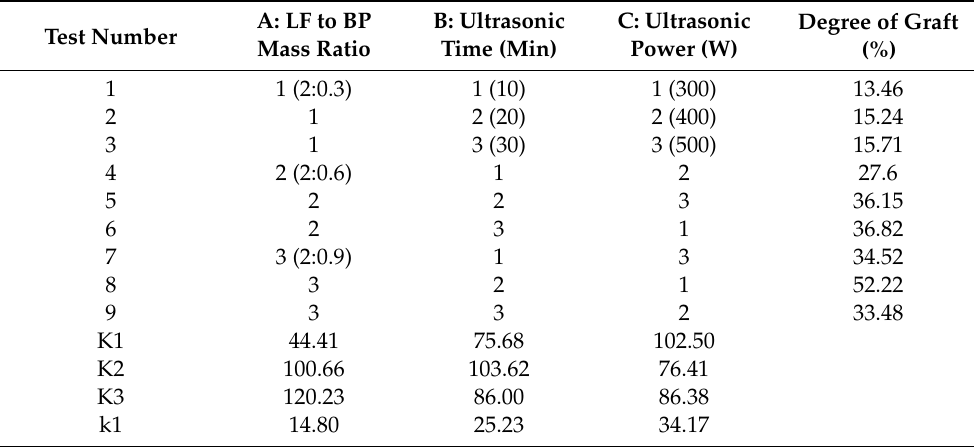
Table 1. Orthogonal experimental arrangement and test